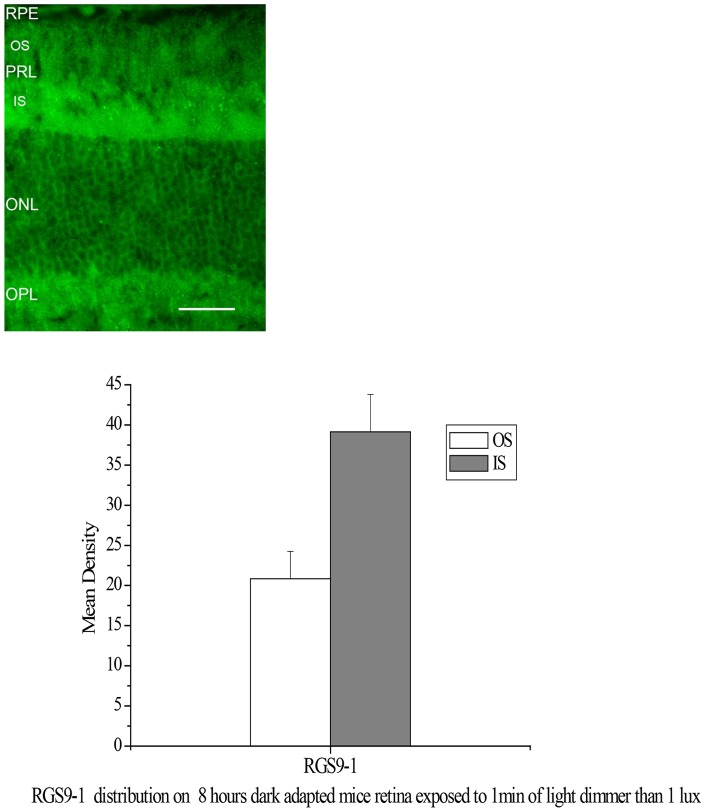
Immunostaining of RGS9-1 on an 8 hours dark adapted mouse retina exposed to 1 min of light dimmer than 1 lux.Upper panel: There is clear RGS9-1 staining in the rod outer segment layer, though staining in inner segment layer is much stronger. Labels are the same as in Fig. 1. Lower panel: Analysis of the average levels of RGS9-1 in the outer segment layer (OS) and inner segment layer (IS); n = 8. Labels are the same as in Fig. 1.